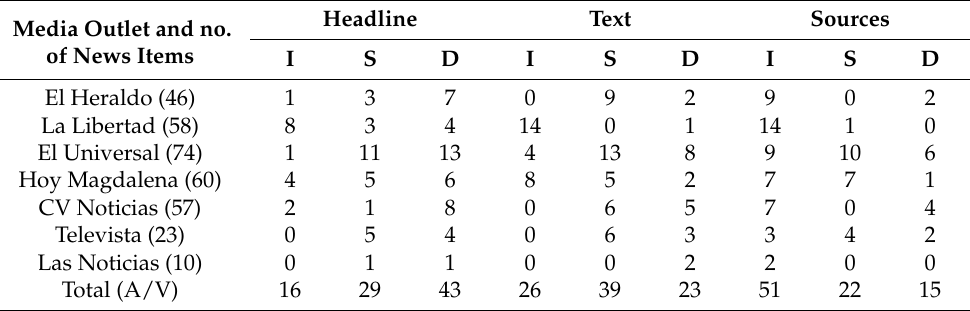
Table 4. Comparison of town hall press releases and press and TV news items (Source: Authors). Media Outlet and